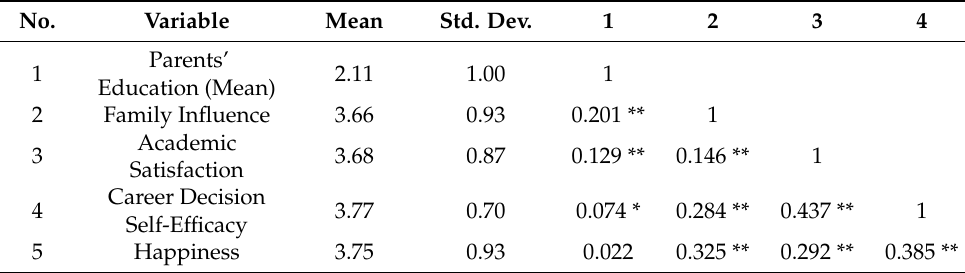
Table 2. Means, standard deviations, and correlations.